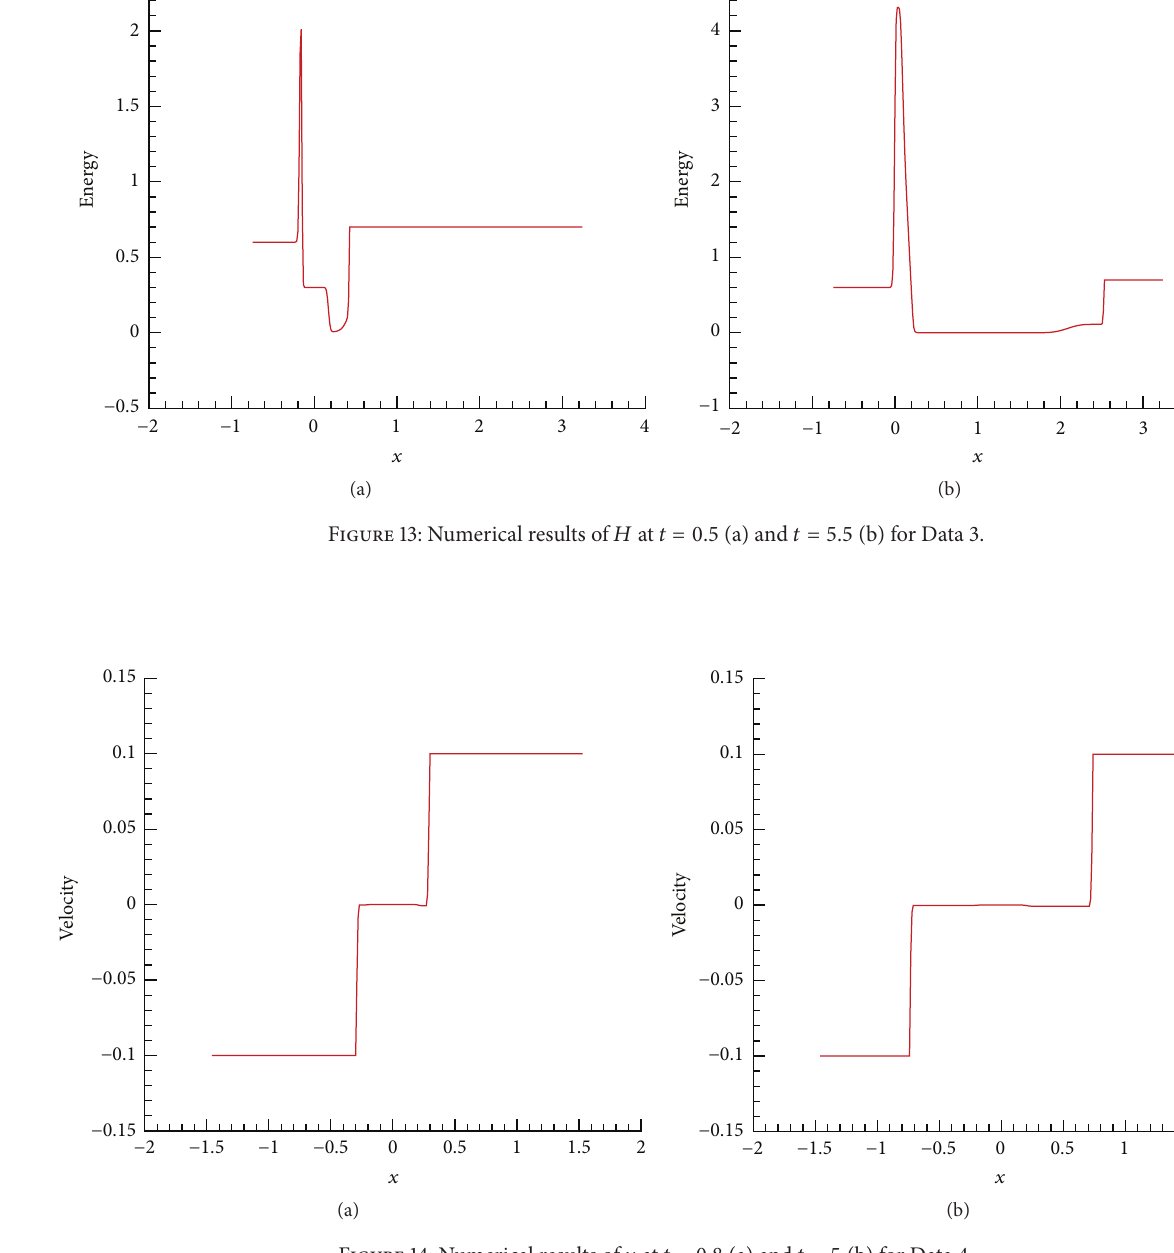
Figure 14: Numerical results of 𝑢 at 𝑡 = 0.8 (a) and 𝑡 = 5 (b) for Data